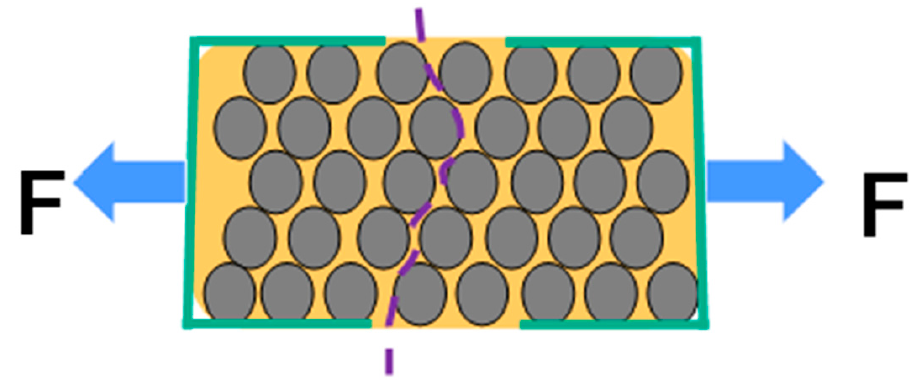
Figure 9. Illustration of a conventional unidirectional ply. The epoxy cracks at a low load (purple dash line).